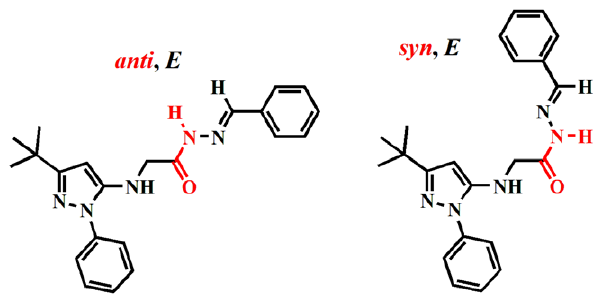
Figure 5. Probable conformational isomers of the NAH derivative 4